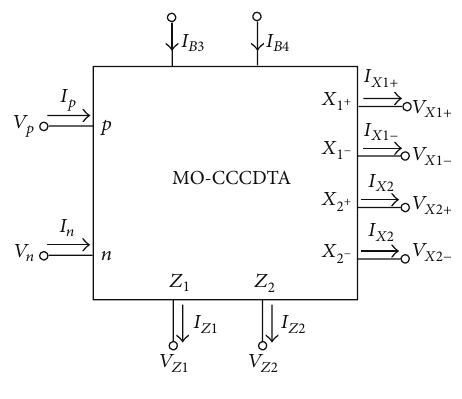
Figure 1: MO-CCCDTA symbol [25].